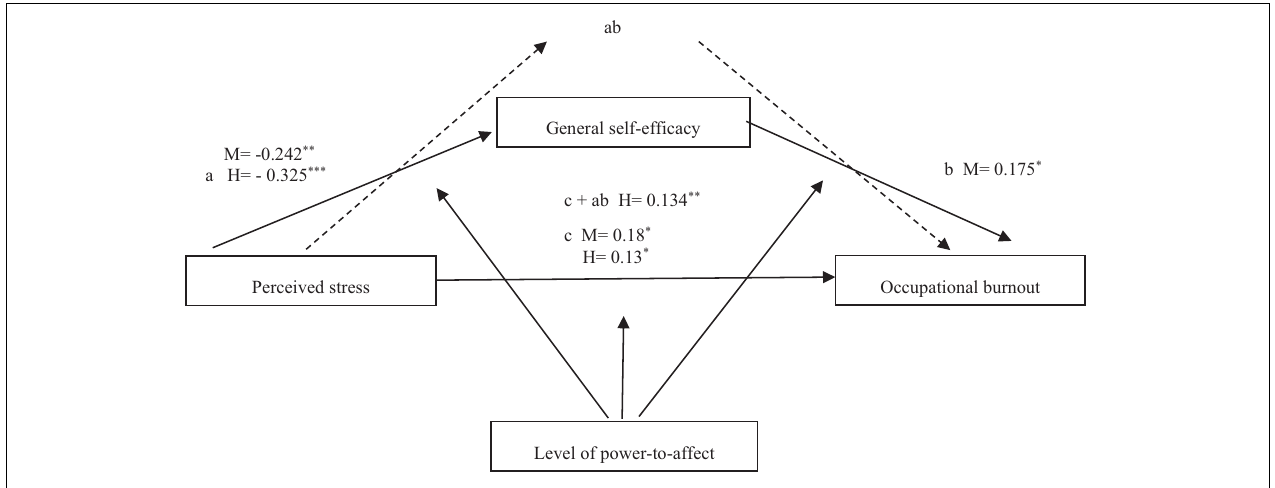
FIGURE 2 | Model 2. Relationships between perceived stress, general self-efficacy and occupational burnout moderated by level of power-to-affect in a group of Polish ECD’s. L = low level of power-to-affect. M = medium level of power-to-affect. H = high level of power-to-affect. ∗ β is significant at the 0.05 level. ∗∗ β is significant at the 0.05 level. ∗∗∗ β is significant at the 0.05 level. For the readability of the graph, the graphic markings of irrelevant paths were omitted.